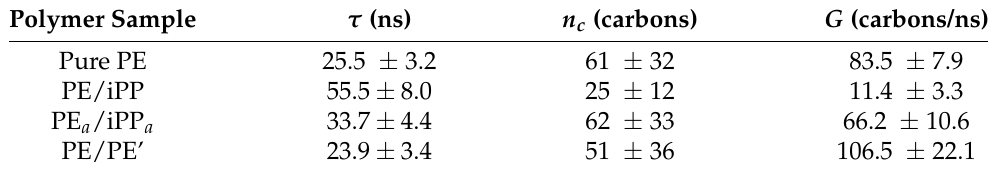
Figure 5. ( a ) Growth of the largest nucleus in eight simulations of isothermal nucleation of pure PE oligomers; ( b ) mean-first-passage time (MFPT) for the largest crystalline nucleus reaching size n max in pure PE oligomers, fitting to the classical nucleation theory (curve); incubation time τ pure marked by a dashed line. Table 1. Fitting parameters of MFPT for different polymer